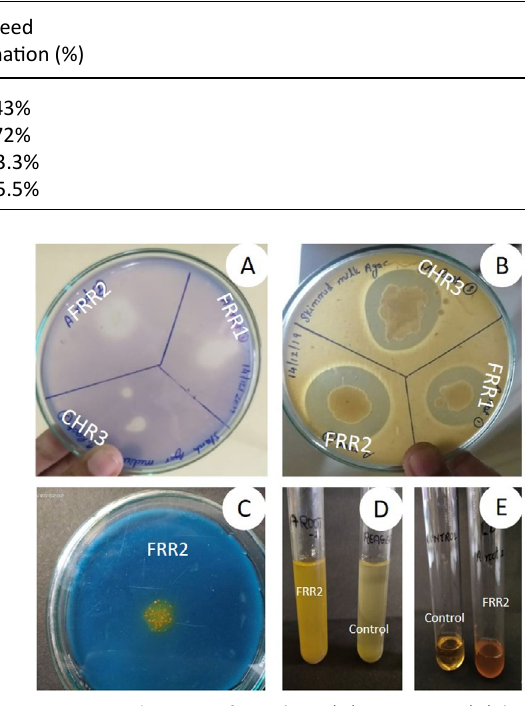
Fig. 2. Production of amylase (A), protease (B) by endophytes (FRR1, FRR2, and CHR3) and nitrogen fixation (C), ammonia (D), and Indole acetic acid (E) of